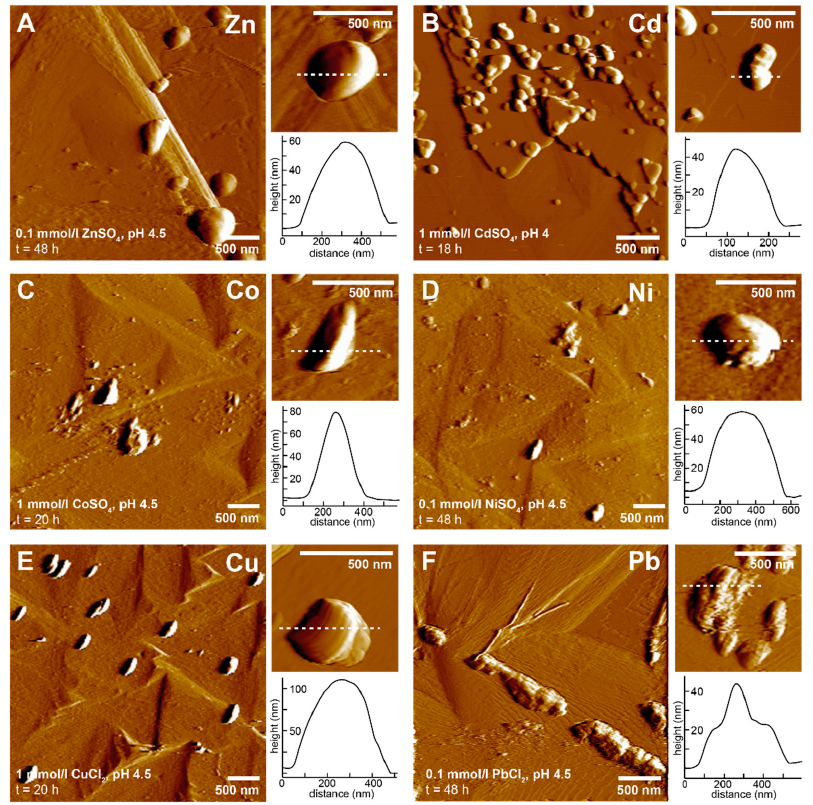
Figure 3. AFM deflection images (acquired in air) and height profiles of nanoparticles and particle clusters on brucite surfaces formed during ex situ experiments. Experimental conditions were ( A ) 0.1 mmol/L ZnSO 4 , pH 5, 48 h; ( B ) 1 mmol/L CdSO 4 , pH 4, 18 h; ( C ) 1 mmol/L CoSO 4 , pH 4.5, 20 h; ( D ) 0.1 mmol/L NiSO 4 , pH 4.5, 48 h; ( E ) 1 mmol/L CuCl 2 , pH 4.5, 20 h; and ( F ) 0.1 mmol/L PbCl 2 , pH 4.5, 48 h. The locations of the height profiles are indicated by dashed lines in the corresponding AFM images. Prior to the ex situ experiments, all of the surfaces were exposed to the corresponding solutions for ~2 h in the AFM fluid cell under stop-flow conditions.